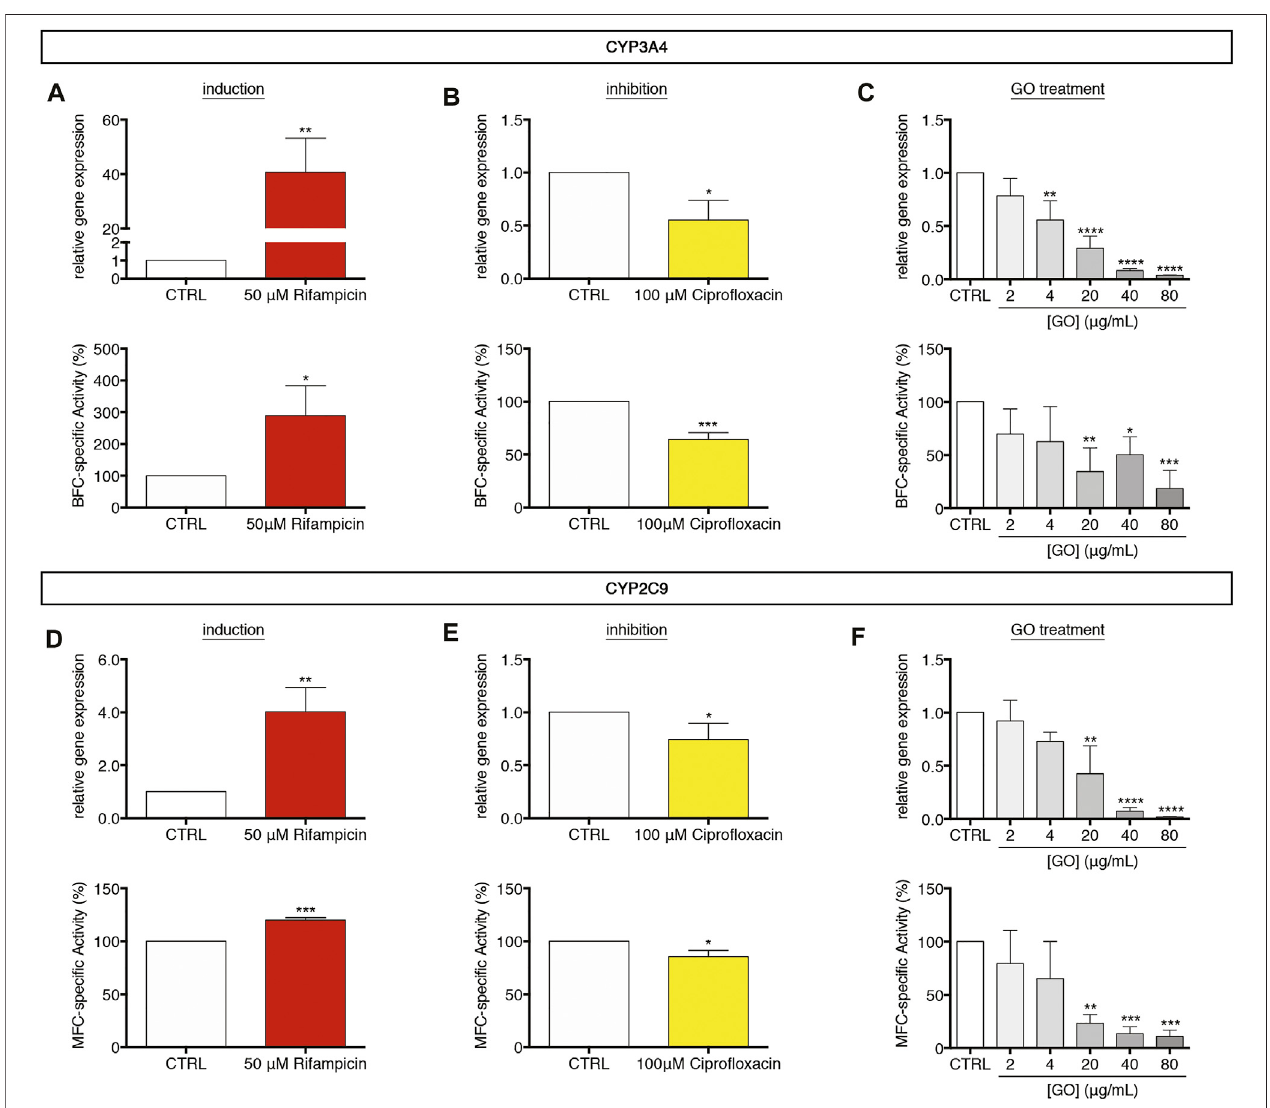
FIGURE 4 | Modulation of the cytochrome P450 system in upcyte ® hepatocytes upon sub-lethal GO exposure. (A,B) Relative gene expression and BFC-speci fi c metabolicactivityofCYP3A4incellstreateddailyupto72 hwith50 μ MRifampicin (A) or100 μ MCipro fl oxacin (B) incomparisontountreatedcells(indicatedasCTRL). Results are expressed as means ± SD values of three independent experiments. The symbols “ * ” , “ ** ” and “ *** ” refer to p ≤ 0.0247, p = 0.0052 and p = 0.0006, respectively, calculated versus CTRL (unpaired t -Test). (C) Relative gene expression and BFC-speci fi c metabolic activity of CYP3A4 in GO-treated cells in comparison to CTRL. Results are expressed as means ± SD values of three independent experiments. The symbols “ * ” , “ ** ” , “ *** ” and “ **** ” refer to p = 0.0164, p ≤ 0.0017, p = 0.0002 and p < 0.0001 respectively, calculated versus CTRL (ordinary one-way ANOVA). (D,E) Relative gene expression and MFC-speci fi c metabolic activity ofCYP2C9incells treateddaily upto72 hwith50 μ M Rifampicin (D) or 100 μ MCipro fl oxacin (E) in comparison toCTRL. Results are expressed asmeans ±SD values of three independent experiments. The symbols “ * ” , “ ** ” and “ *** ” refer to p ≤ 0.0444, p = 0.0047 and p = 0.0001, respectively, calculated versus CTRL (unpaired t -Test). (F) Relative gene expression and MFC-speci fi c metabolic activity of CYP2C9 in GO-treated cells in comparison to CTRL. Results are expressed as means ± SD values of three independent experiments. The symbols “ ** ” , “ *** ” and “ **** ” refer to p ≤ 0.0019, p ≤ 0.0007, and p < 0.0001, respectively, calculated versus CTRL (ordinary one-way